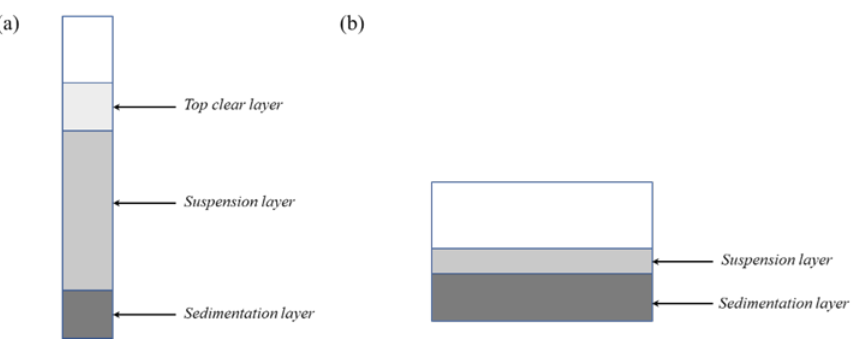
Figure 3. ( a ) Normal sedimentation test. ( b ) Quick sedimentation test.